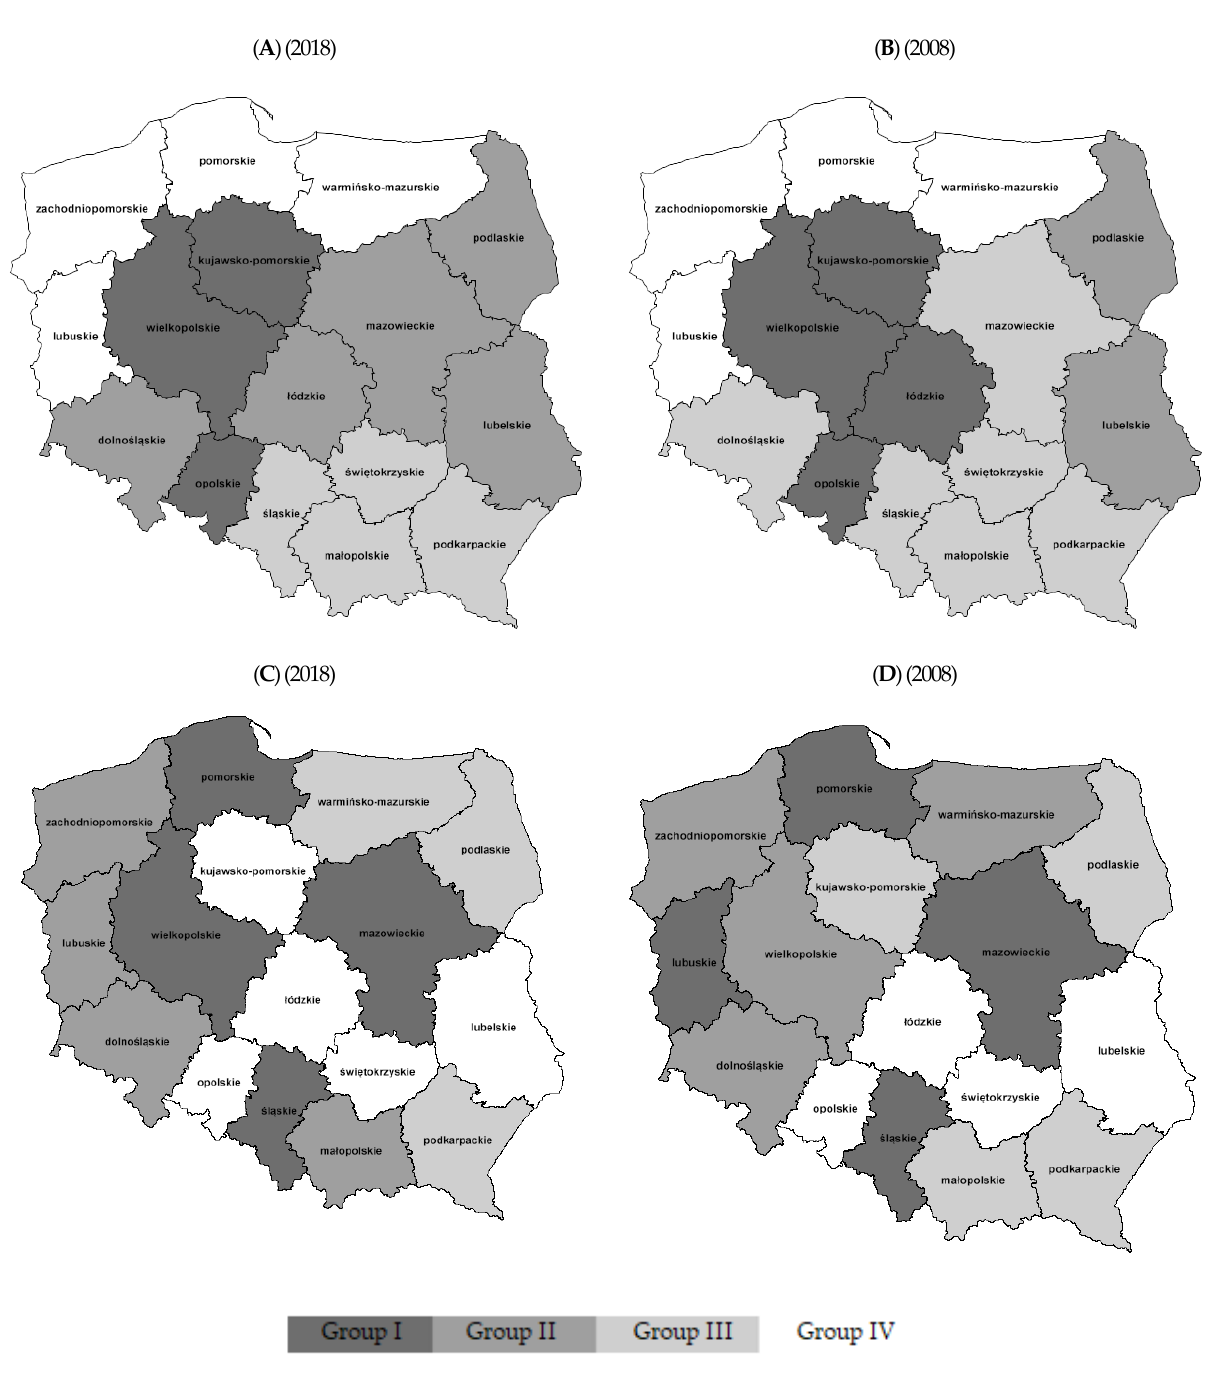
Figure 1. Quartile groups for measures of synthetic agricultural potential of Polish voivodeships in 2008 and 2018. ( A , B ) (agriculture) ( C , D ) (development). Source: own study based on the BDL CSO data.